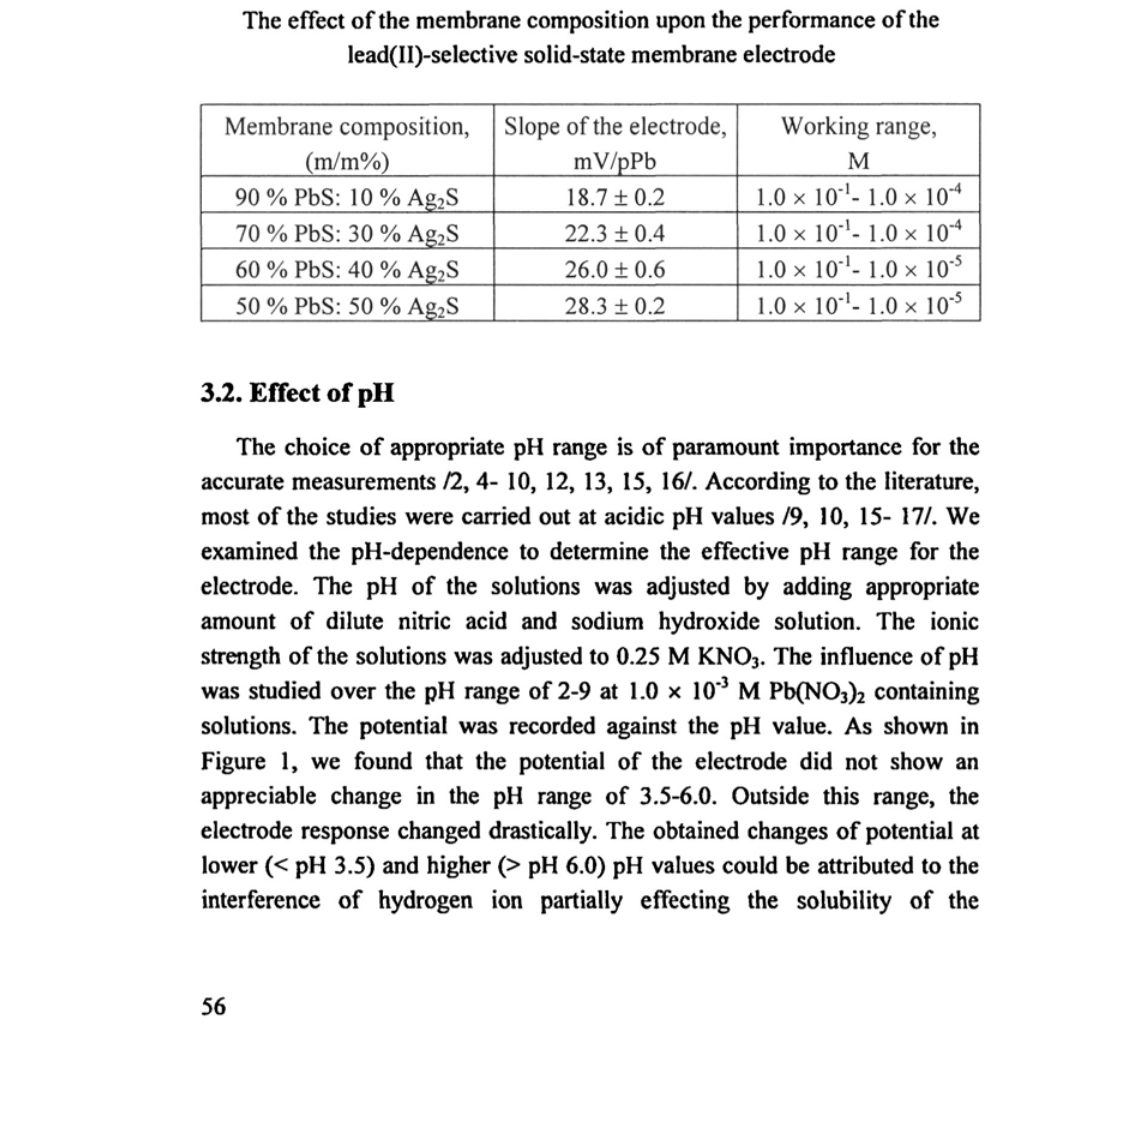
lead(H)-selective solid-state membrane electrode Membrane